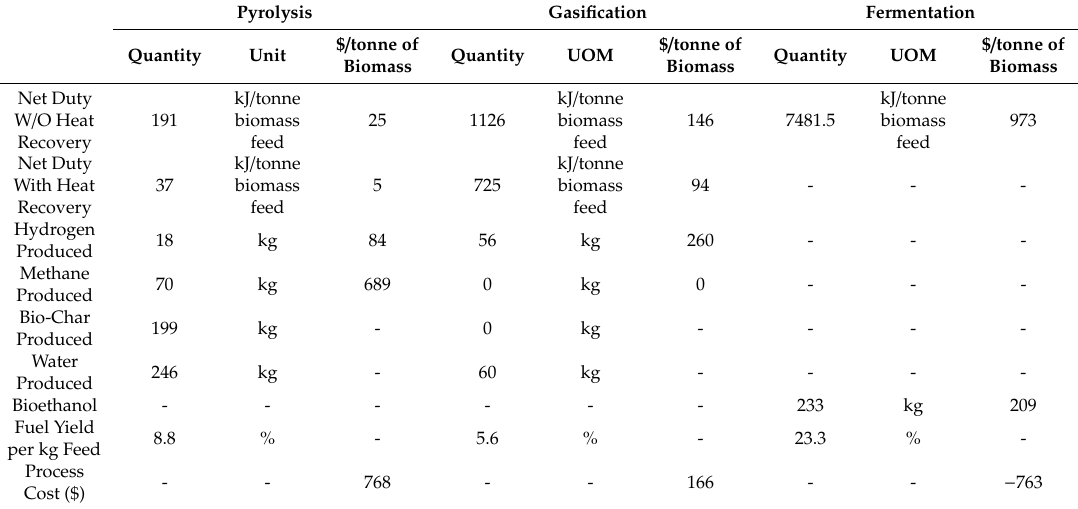
Table 6. A brief economic